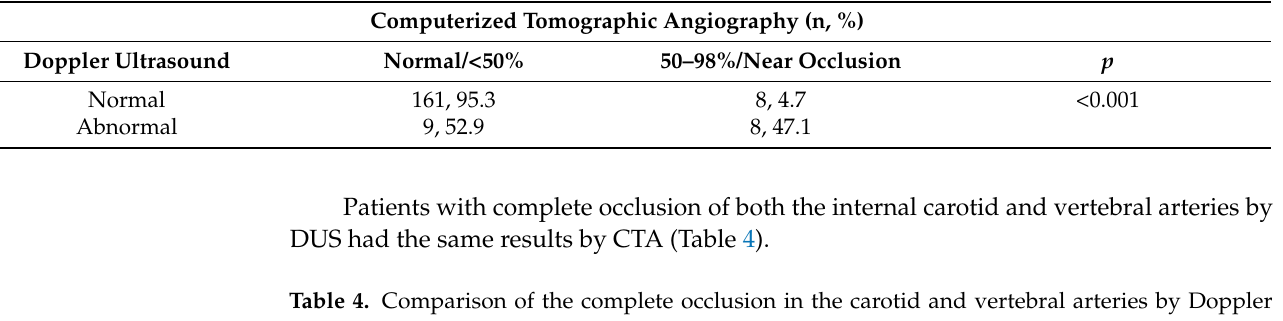
Table 3. Comparison of the degree of stenosis of the right (RT) and left (LT) vertebral artery by Doppler Ultrasound (DUS) and Computerized Tomographic Angiography (CTA).